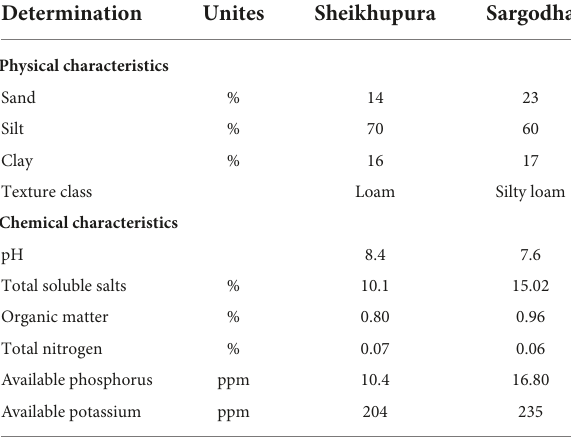
TABLE 1 Physical and chemical characteristics of experimental soil.